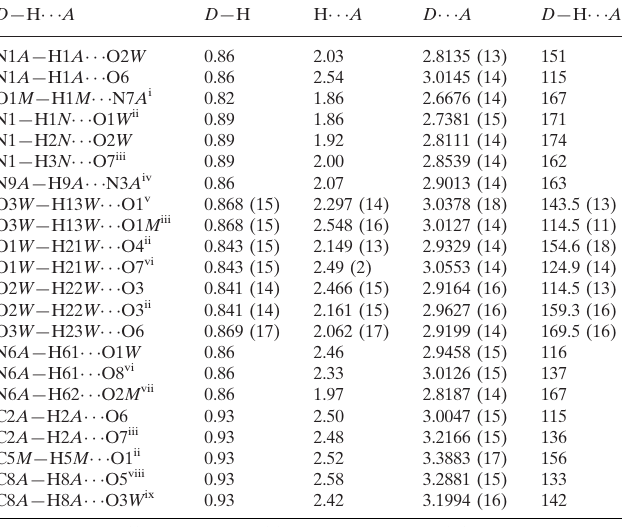
Hydrogen-bond geometry (A˚ , (cid:4)